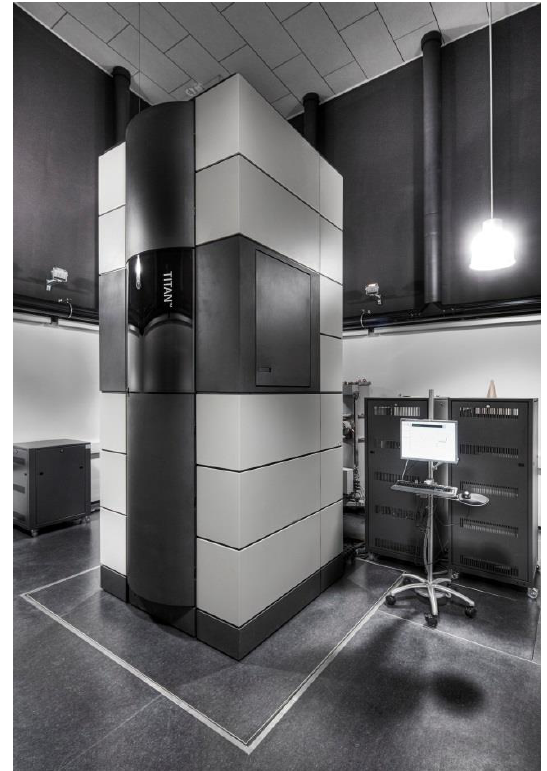
Figure 1: FEI Titan G3 50-300 PICO transmission electron microscope (photograph by courtesy of Christian Lüning